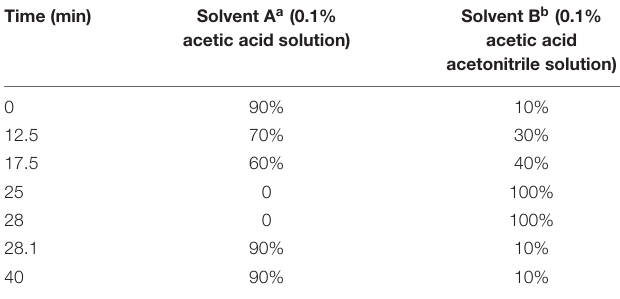
TABLE 1 | The gradient solution program of high-performance liquid chromatography